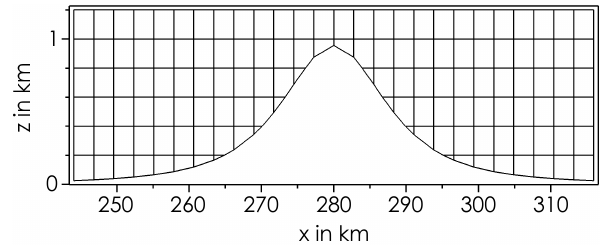
Figure 16. Computational grid around the mountain for an x - z cut plane at y = 1.38 km (cell center).